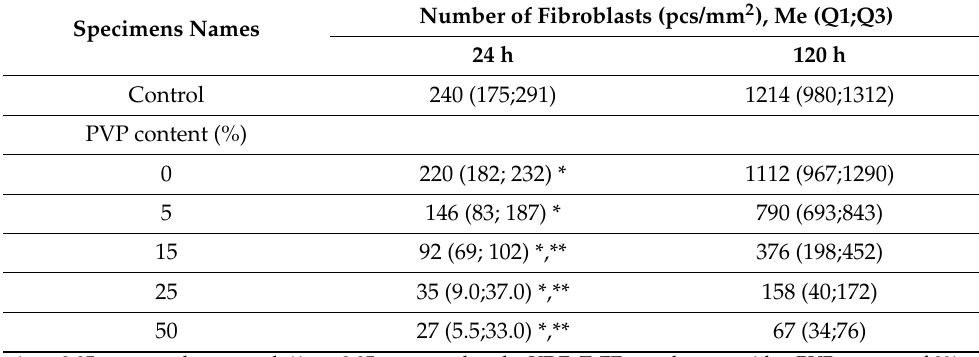
Table 3. Cell growth and proliferation after 24 and 120 h of